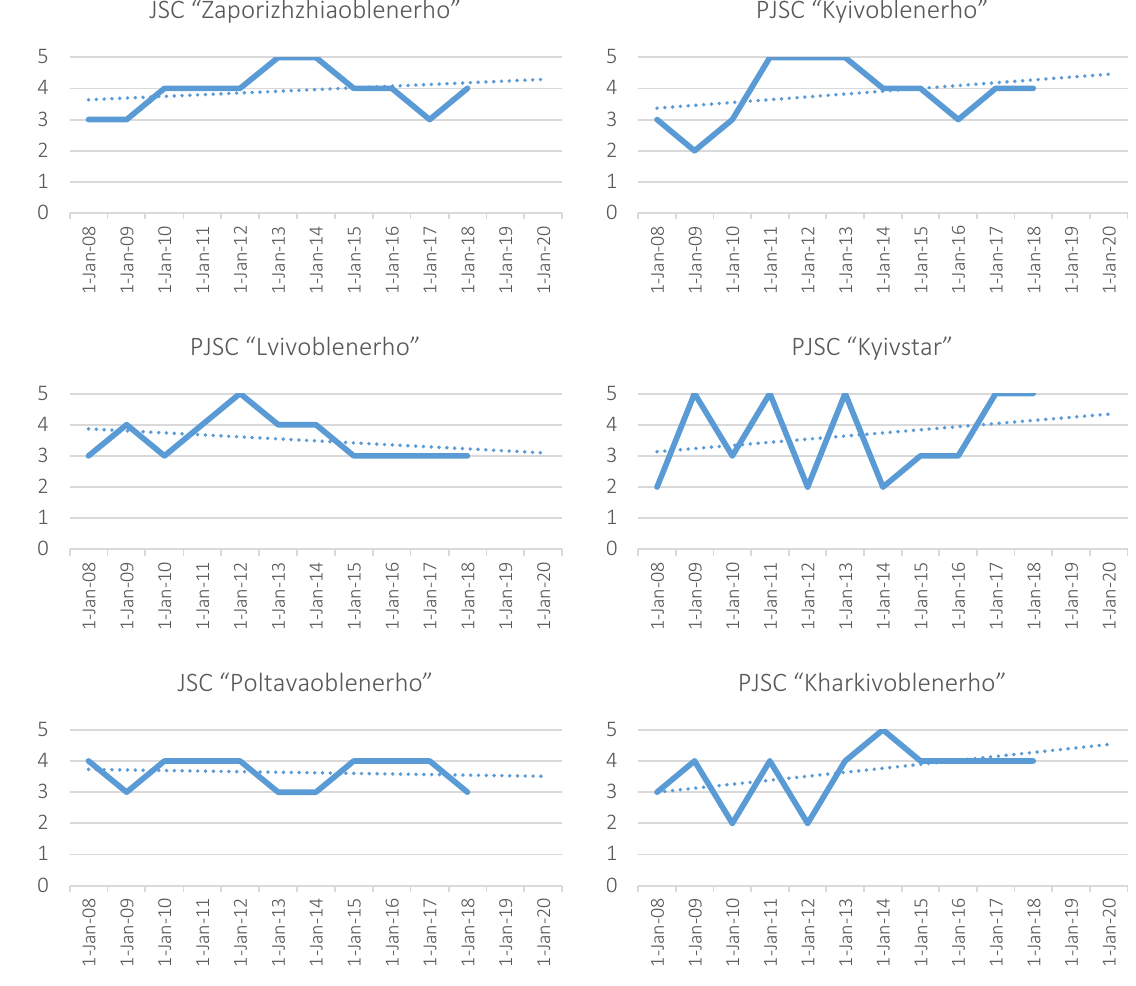
Figure 5. Group of Ukrainian unstable companies (within the relevant